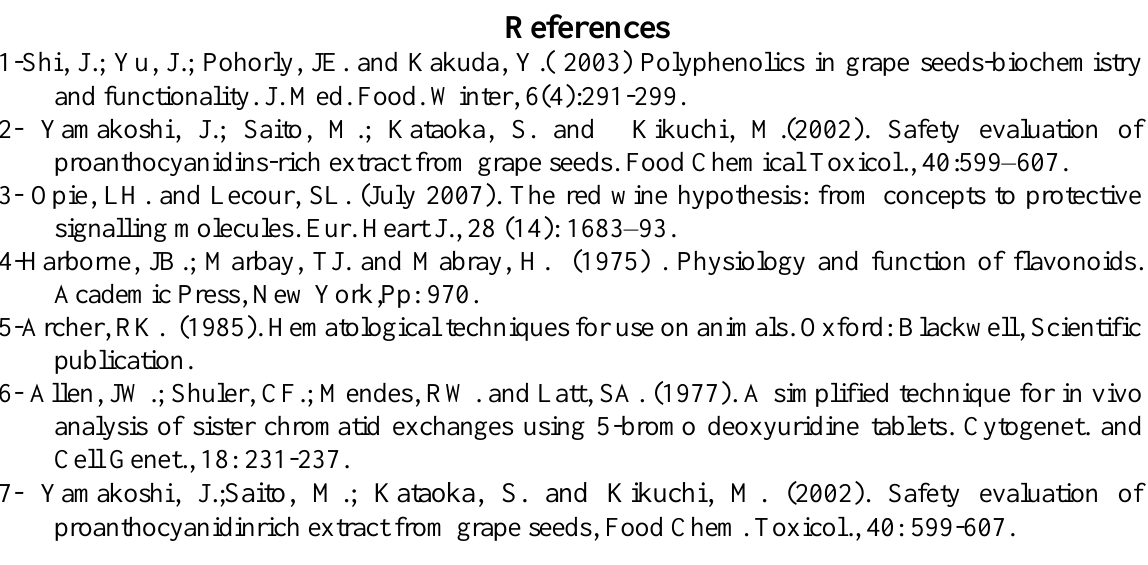
Fig (19): Histopathological section of Spleen treated with ethanolic extract of grape seed at dose (300mg/kg b.w orally) showing deposition of amyloid like substance causing pressure atrophy to lymphoid tissue (H&E x400 ).